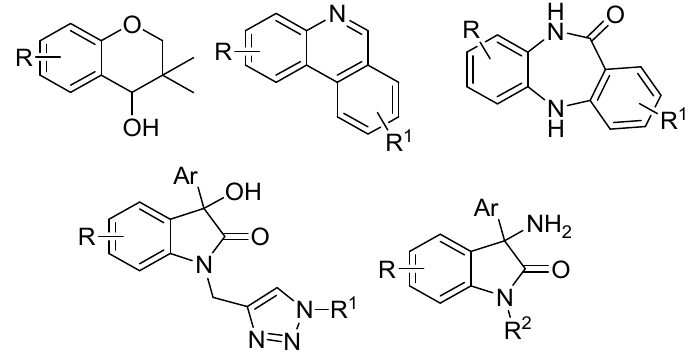
Figure 1. Examples of some targets developed.